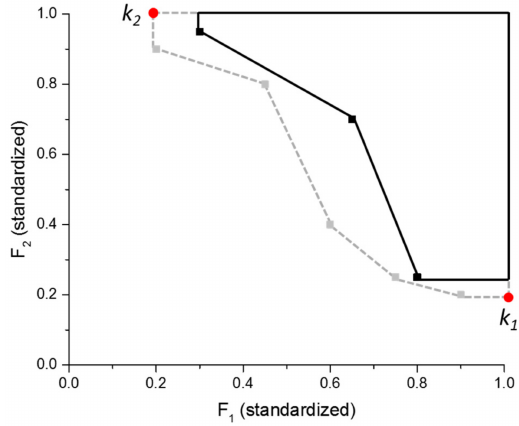
Figure 8. Dominated area calculation for generation i (black solid line) and i + 1 (grey dotted line), and the maximum points k 1 and k 2 (red